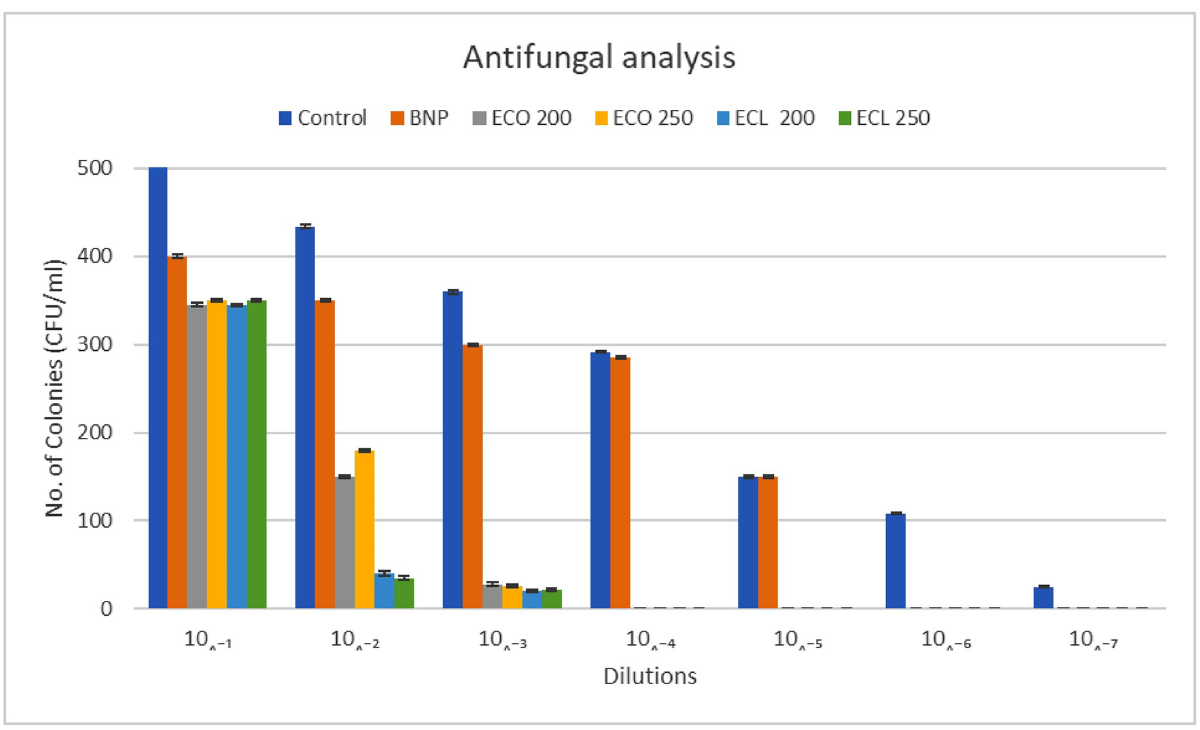
Fig 4. CFU counts of C. albicans on the surface of control tissue conditioner, blank chitosan nanoparticles, and chitosan nanoparticles loaded with essential oils (in both concentrations) based tissue conditioners. The graph depicts that the experimental groups show significantly low CFU/ mL compared to the control and the blank chitosan nanoparticles.